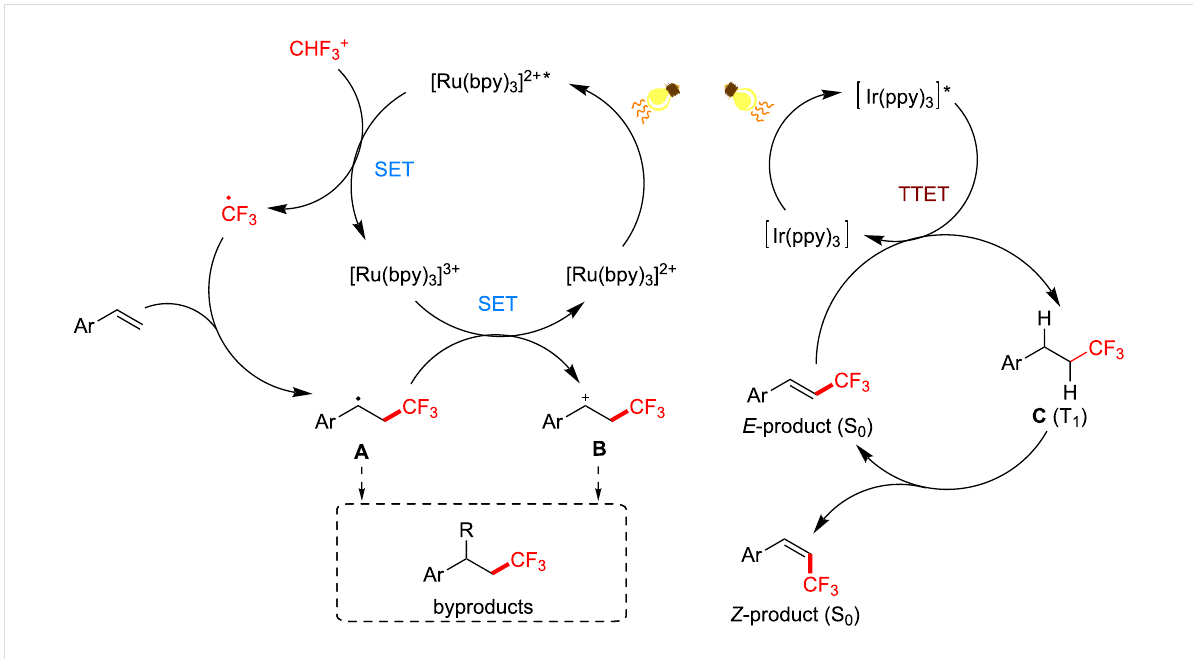
Scheme 43: Reaction mechanism for photosensitized TFM of styrenes to afford E - or Z